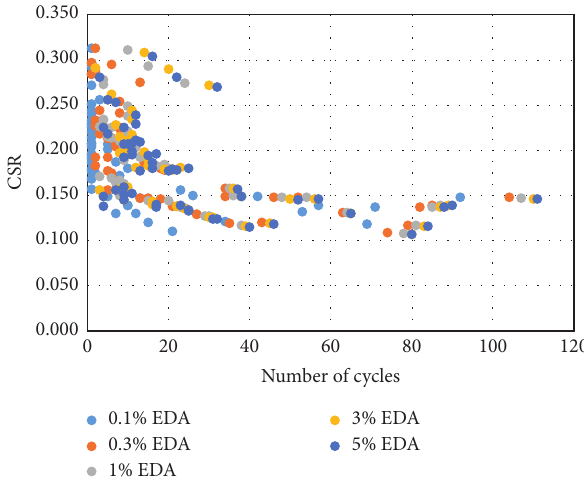
Figure 1: Data from Taylor [29] comparing number of cycles to initiate varying strains.